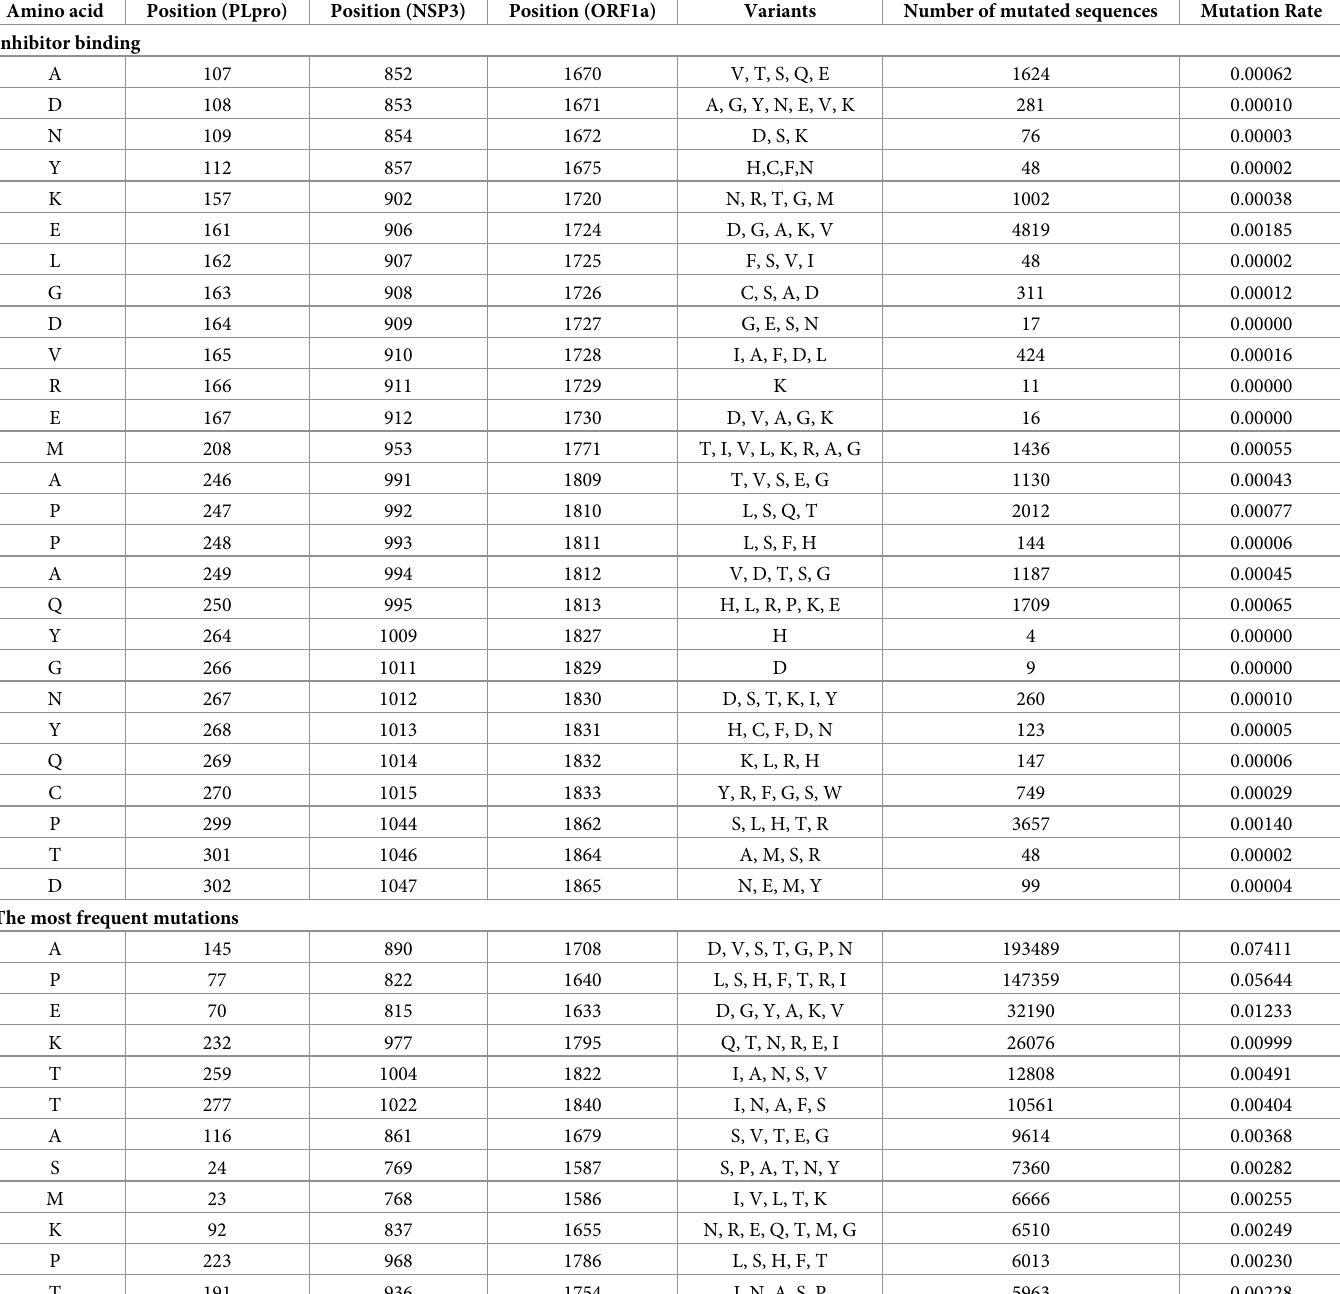
Table 1. Selected amino acid variants of papain-like protease from SARS-CoV-2. Frequent mutations are those with mutation rate > 0.002. Residues from inhibitor binding site were selected based on residue-ligand distance (no more than 6 Å ) calculated for all available PLpro-ligand crystal structures. Amino acids in Variants column are sorted from most to least frequent. All found variants are available in Supplementary